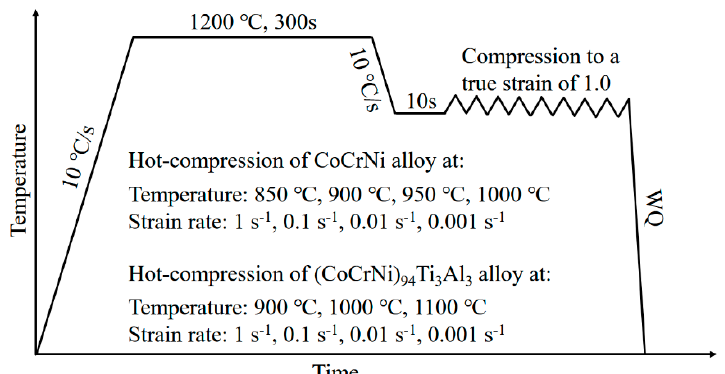
Figure 1. Schematic diagram showing the experimental procedure and conditions for the hot compression of the CoCrNi and (CoCrNi) 94 Ti 3 Al 3 alloys.